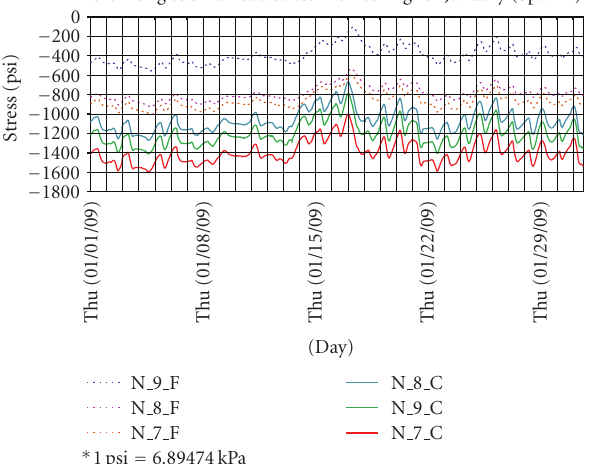
Figure 4: North longitudinal load stress monitoring for span two (January).